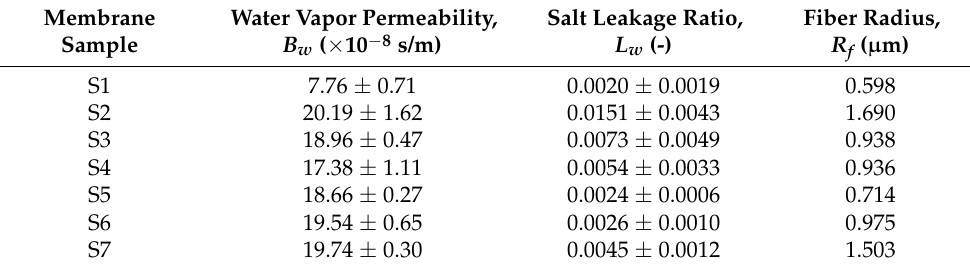
Table 4. Secondary (evaluated) properties of fabricated